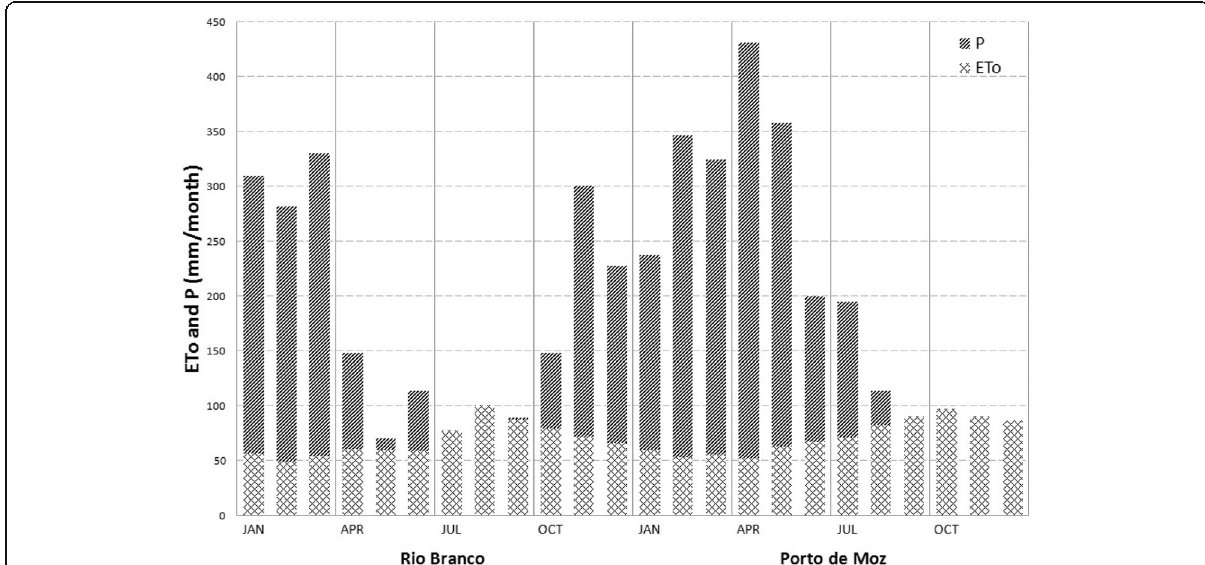
Fig. 2 Mean monthly precipitation ( P ) and reference evapotranspiration (ET 0 ) values for the period 2011 to 2013 at the Rio Branco (left) and Porto de Moz (right) stations (source INMET, 2017). Two major seasons are observed: (1) the rainy season starting from December until May and (2) the dry season from June to November. These patterns are more pronounced at the Porto de Moz station near the East Coast. Rio Branco reveals water shortage during July (ET 0 =78.3; P =38.2mm/month) and August (ET 0 =100.2; P =58.6mm/month). The dry period in Porto de Moz is also longer, suggesting an east-west gradient from the coast to the upper parts of the Amazon basin. Over the 3 years (2011 to 2013), there was a water-deficit at Porto de Moz, in September